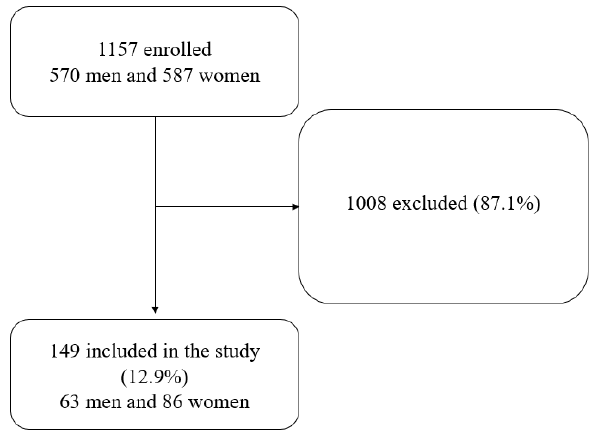
Figure 1. Flowchart of the study recruitment process. All data including demographics (age, gender, age at CF diagnosis), body mass index (BMI), genetic screening for CFTR mutations (F508del, G542X, N1303K, and other), CFRD duration, and chronic infection with microorganisms in the sputum ( Pseudomonas